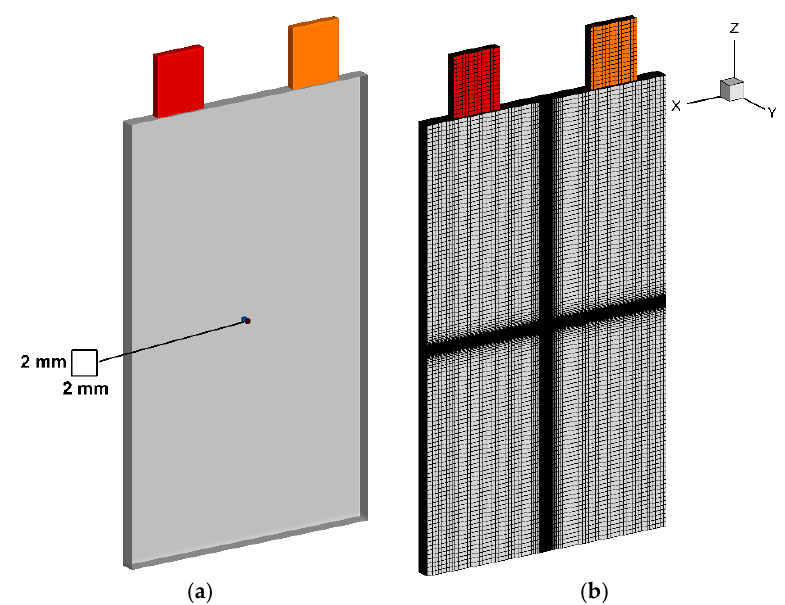
Figure 3. Schematic of ( a ) geometry; ( b ) mesh of internal shorting process modeling.